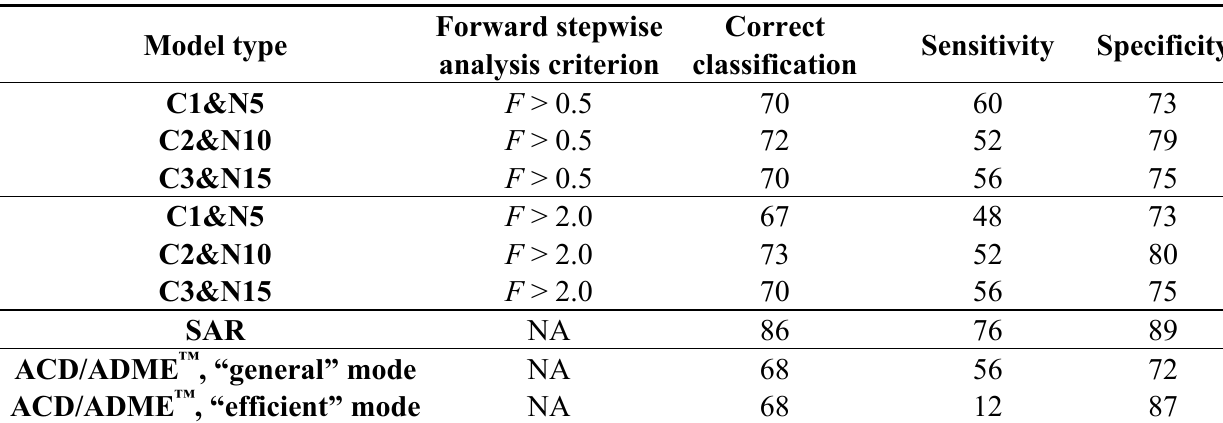
Table 3. External validation statistics (%) of the CYP3A4